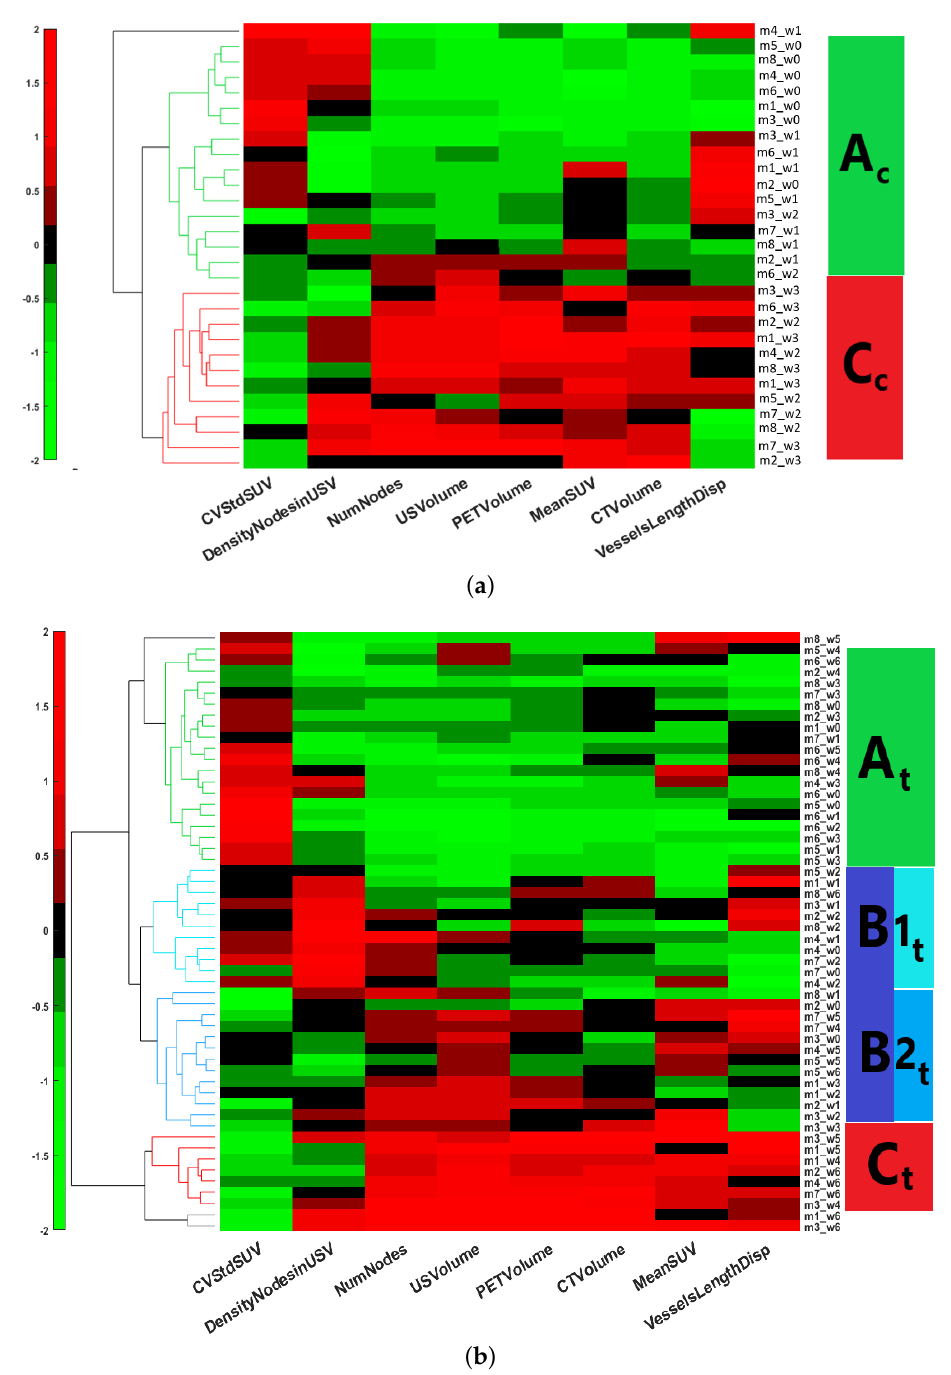
Figure 4. Heatmap and hierarchical clustering performed ( a ) on the D con D suni dataset. Two clusters ( A c , C c ) were identified in ( a ) and 4 clusters ( A t , B 1 t , B 2 t , and C t ) were training identified in ( b